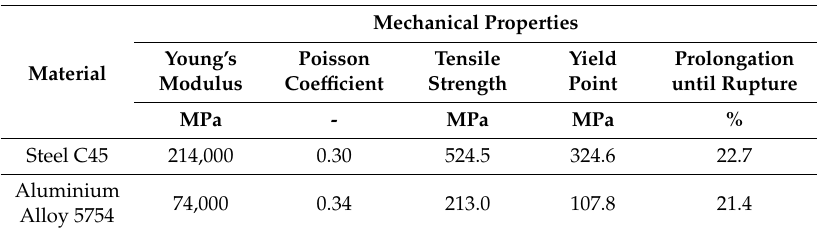
Table 4. Mechanical properties of adherend